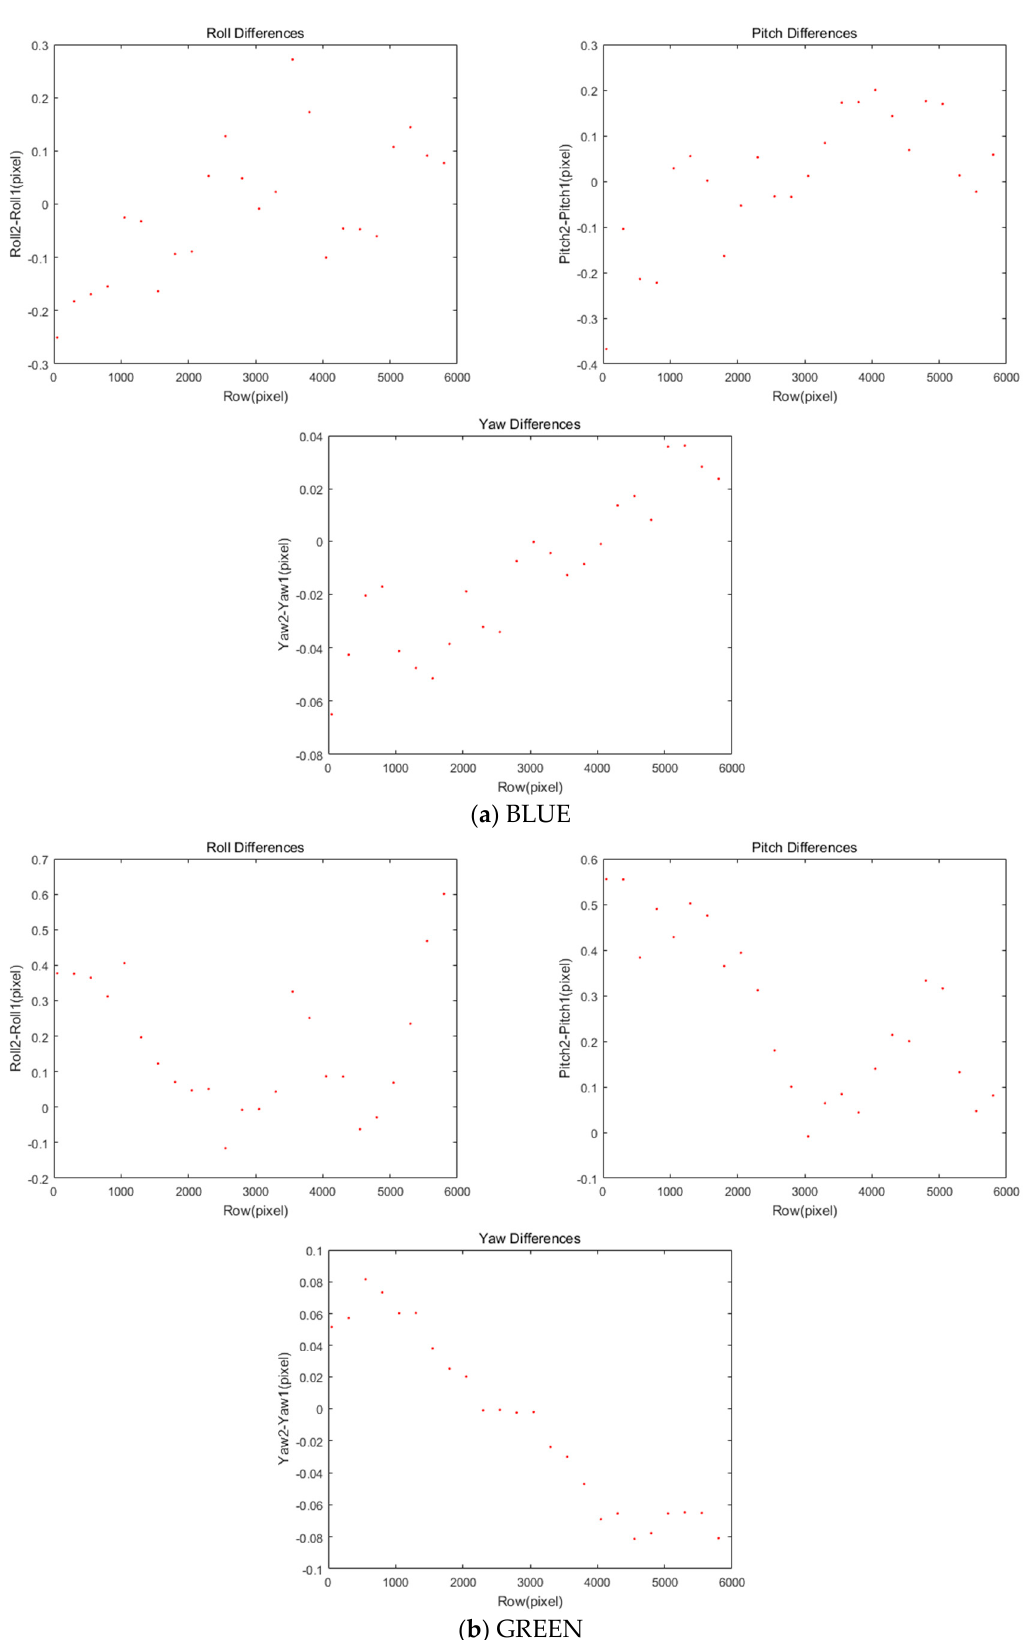
Figure 7. Attitude changes in KOMPSAT-2 in row coordinates.